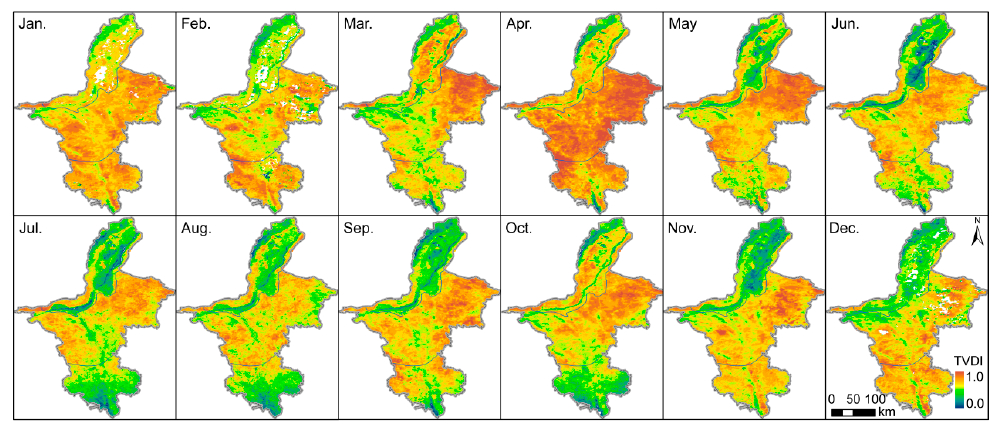
Figure 9. The drought map monitored by TVDI in Ningxia Province, China, in 2005 (white is invalid data).